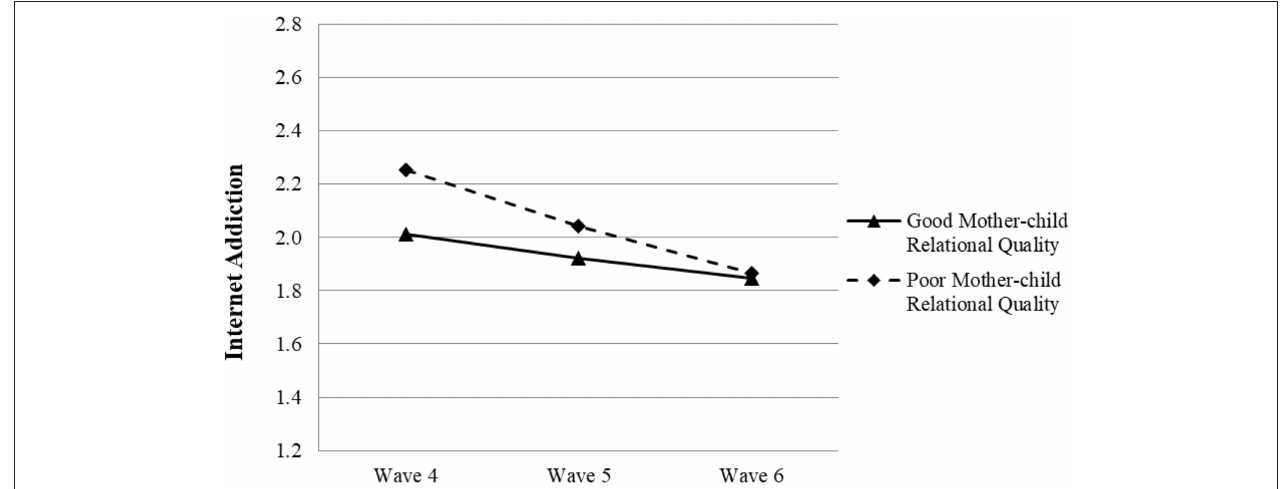
FIGURE 4 | Growth trajectories of adolescent Internet addiction as a function of mother–child relational quality. The figures were plotted based on Model 4c shown in Table 6 . Good quality indicates 1SD higher than the mean value; poor quality indicates 1SD lower than the mean value.